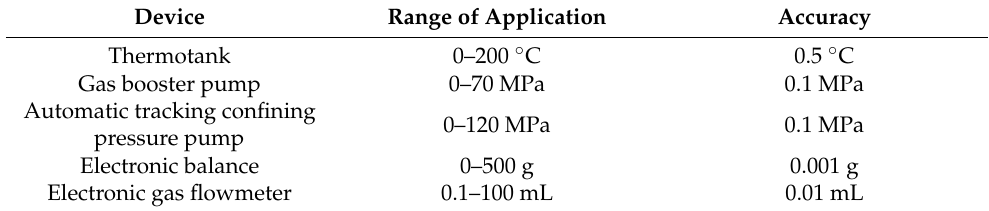
Table 1. Device parameters.